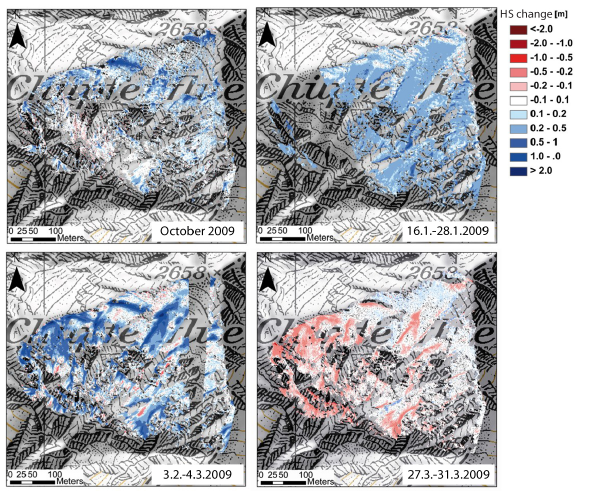
Fig. 7. Snow depth changes (dHS) during different observation